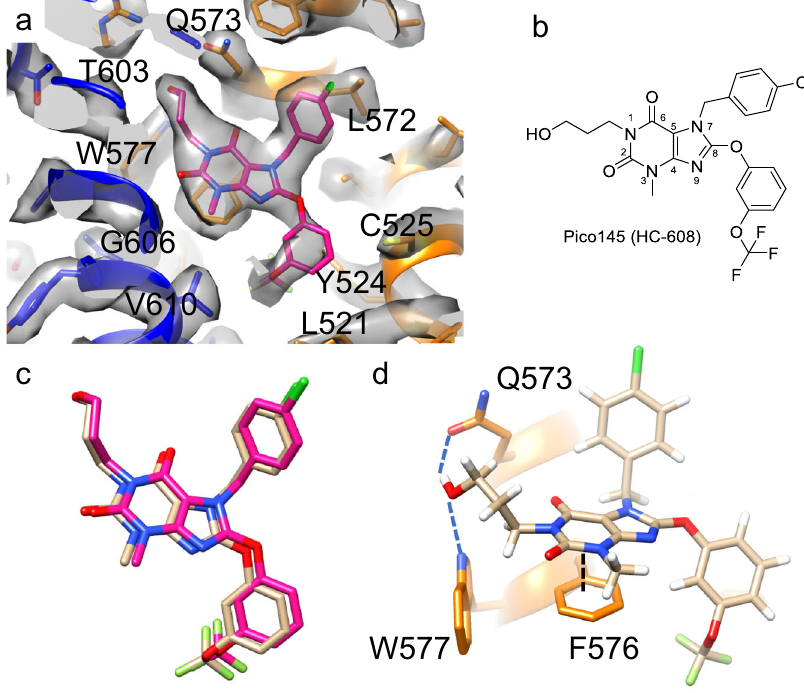
Fig. 3 Analysis of the Pico145-binding site of TRPC5. a The re fi ned structure of the Pico145-binding site within the cryo-EM density map (grey; contour level 0.0583). The binding site spans two monomers: monomer 1 is shown in orange and monomer 2 is shown in blue; Pico145 is shown in magenta. Key residues in the binding site (L521, Y524, C525, L572, Q573, W577, T603, G606 and V610) are labelled. b Chemical structure of Pico145 with the numbering of the xanthine core. c An overlay of the top docking pose of Pico145 (peach) and our fi tted Pico145 molecule (magenta). The top three docking poses are shown in Supplementary Fig. 7. d The top-scoring docking pose suggests that Pico145 hydrogen bonds to Q573 and W577 (dashed blue lines) and π -stacks with F576 (dashed black